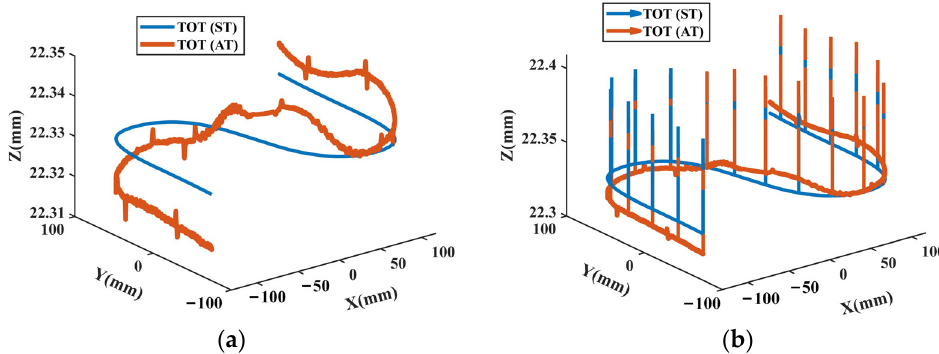
Figure 18. The synthesized ST and AT. ( a ) TTPT of ST and AT; ( b ) TOT of ST and AT.